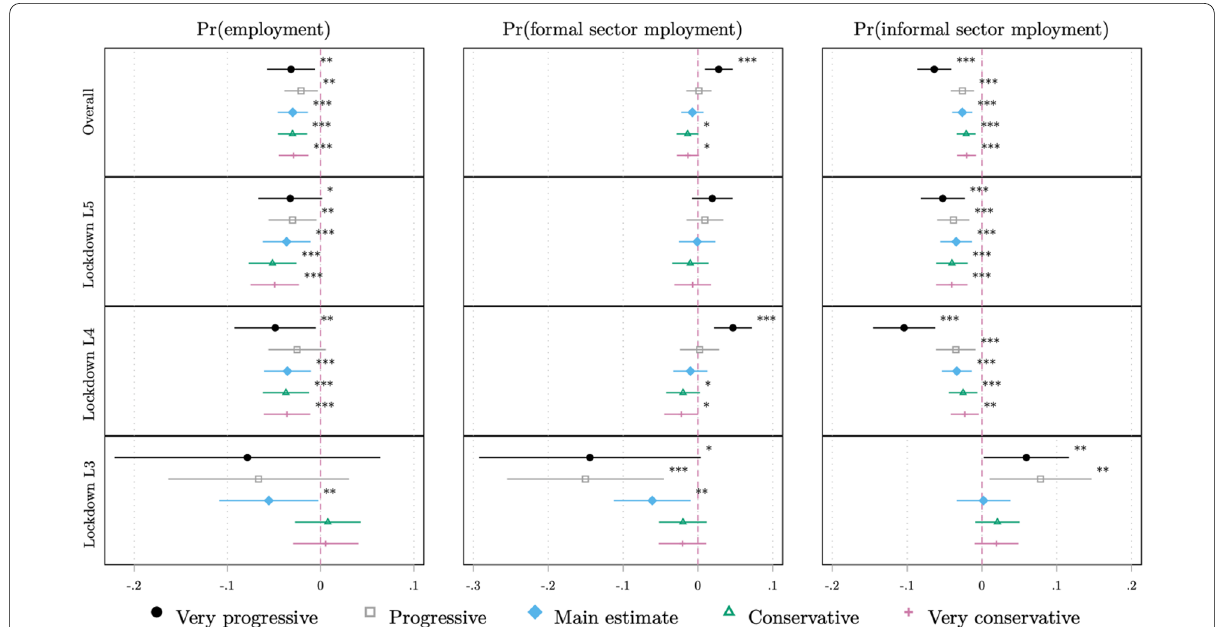
Fig. 3 Coefficient plot of model estimates, by outcome, lockdown stringency level, and industry capacity assumption. γ Author’s own calculations. Source : QLFS 2020Q1 and 2020Q2 (Statistics South Africa 2020b, c). Notes : This figure presents a coefficient plot of estimates of from specification (1) by dependent variable and lockdown level using varying industry capacity assumptions. ‘Very progressive’ workers coded as being permitted to = work if any share of the industry is permitted; ‘progressive’ workers coded as being permitted to work if at least 25% of the industry is permitted; = ‘conservative’ workers coded as being permitted to work if at least 75% of the industry is permitted; ‘very conservative’ workers coded as being = = permitted to work only if 100% of the industry is permitted. Markers represent point estimates and lines represent 95% confidence intervals. Lockdown levels range from 5 (most stringent) to 3 (most lenient). Sample restricted to the working-age population (15–64 years) as of 2020Q1. All model standard errors are clustered at the panel level. Estimated weighted using sampling weights. All models control for a vector of time-varying observable covariates including age, highest education level, and employment type. All models additionally control for individual fixed effects (FEs) and as such time-invariant observables are not included. *** p < 0.01, ** p < 0.05, * p <